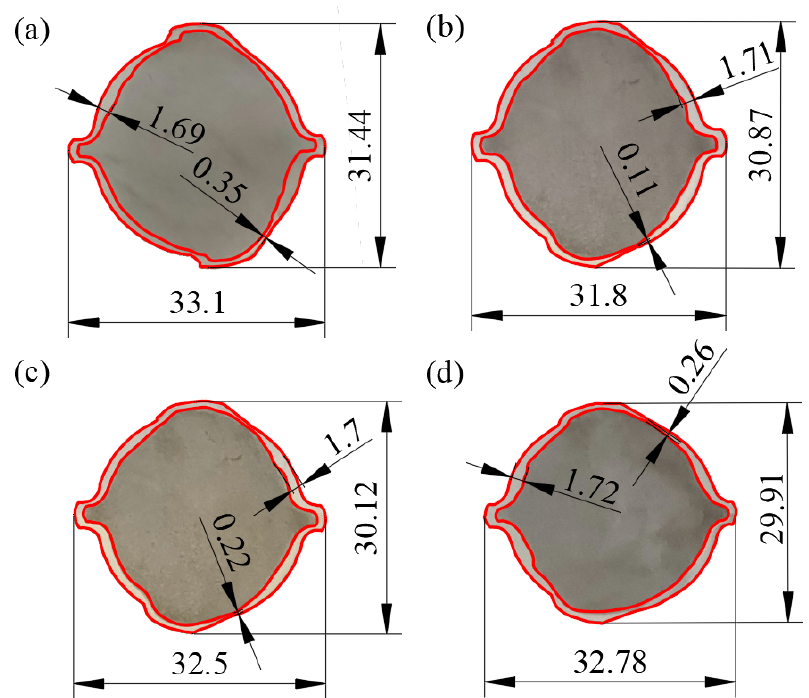
Figure 5. Surface sizes of the ends of various rebars: ( a ) 20MnSiV/316L rebar; ( b ) 35#/316L rebar; ( c ) 45#/316L rebar; ( d ) 55#/316L rebar.